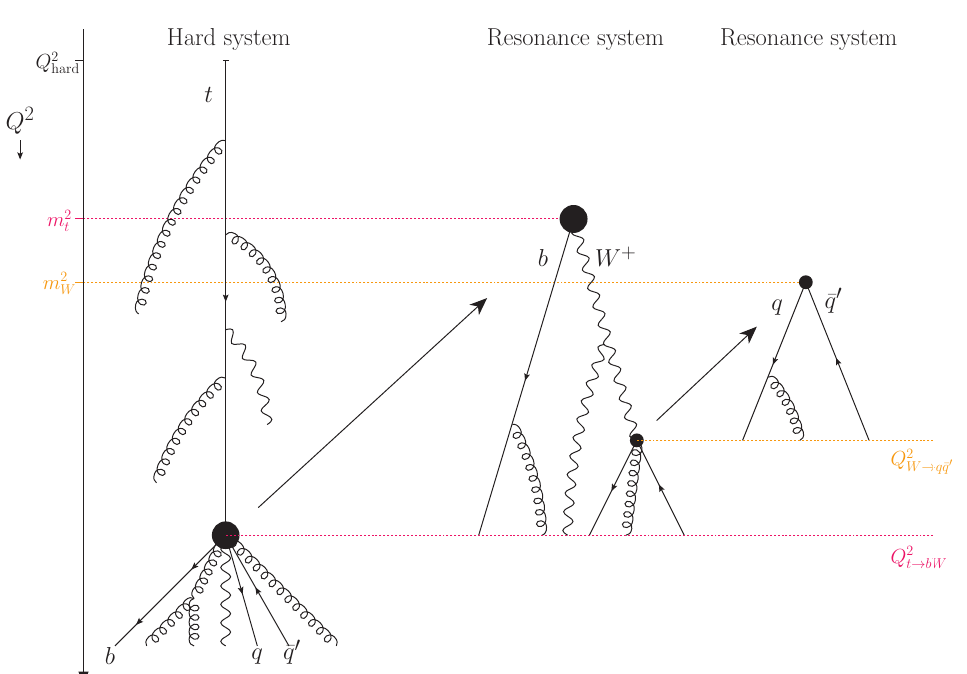
Figure 2: Recursive interleaving of resonance decays with QED and QCD radiation, for a hard event with t → bW followed by W → q ¯ q (cid:48) . The vertical axis represents the evolution scale, from high (top) to low (bottom). The scales m and m represent the t W (BW-distributed) invariant masses of the respective particles, setting upper kinematic limits for each resonance shower. The new aspect is the introduction of the scales Q (typically of order Γ and Γ respectively), below which each of and Q t W t → bW W → q ¯ q (cid:48) the resonance-decay systems are merged into their respective production